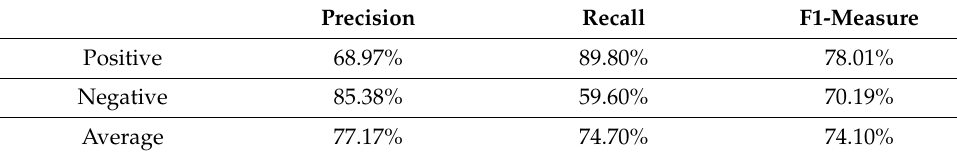
Table 12. Performance evaluation of lexicon baseline